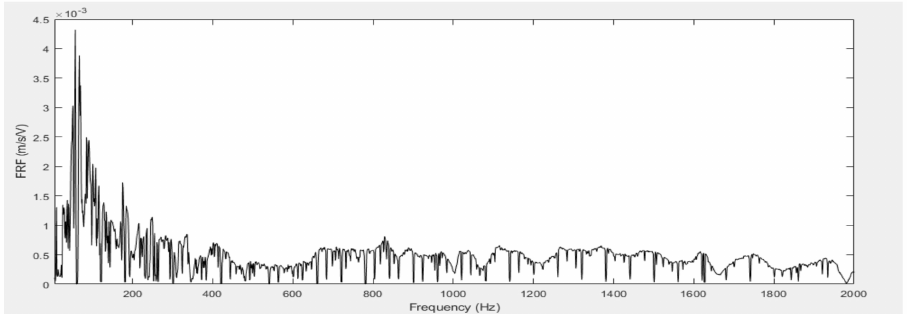
Figure 6. Resonance frequency of the